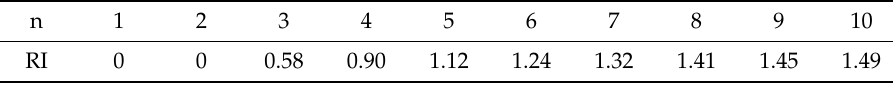
Table 3. Random Consistency Index (RI) 1